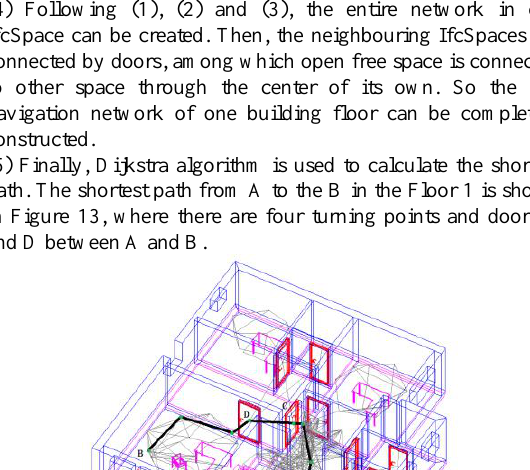
Figure 12. Resulting network for navigation in one IfcSpace (4) Following (1), (2) and (3), the entire network in one